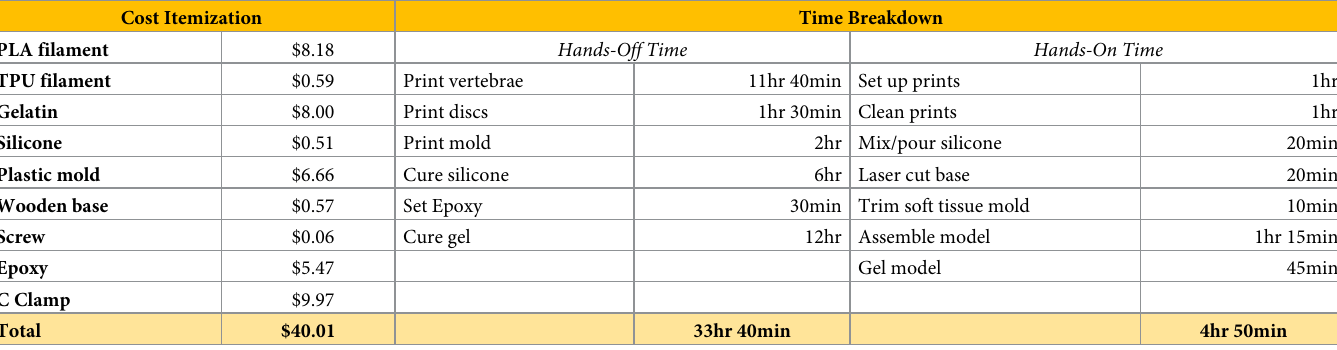
Table 2. Cost itemization and construction time for